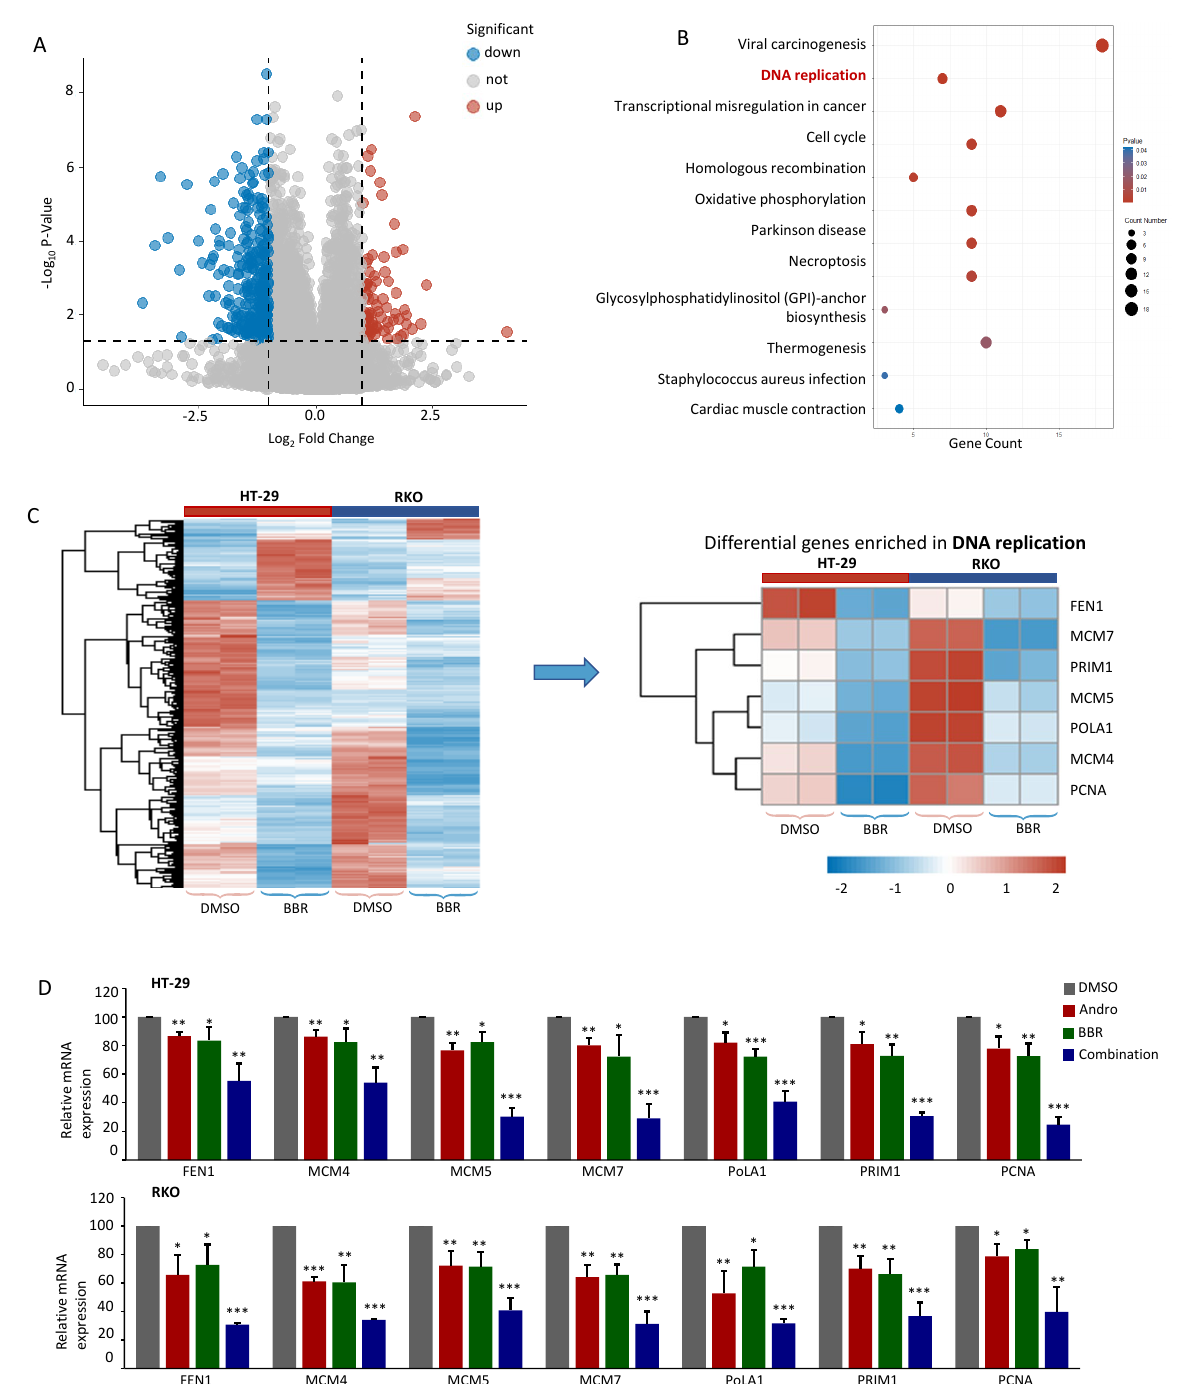
Figure 4. The enhanced anticancer effect of Andrographis and berberine is mediated by the suppres- sion of the DNA replication pathway in CRC. ( A ) The volcano plot obtained from whole-transcriptome profiling analyses of RKO and HT-29 cells after treatment with berberine (|log2 fold change| > 1, p < 0.05); ( B ) The bubble diagram of the KEGG pathway analysis based on the significantly dysregu- lated genes; ( C ) The heatmap of the common differentially expressed genes in both RKO and HT-29 cells and the heatmap of the transcriptional expression of DNA replication-specific genes; ( D ) A bar graph showing the relative mRNA expression of FEN1, MCM7, PRIM1, MCM5, POLA1, MCM4, and PCNA in RKO and HT-29 cells after being treated by berberine, Andrographis and their combination. Statistical Significance: * p < 0.05, ** p < 0.01, *** p < 0.001. BBR, berberine; Andro,